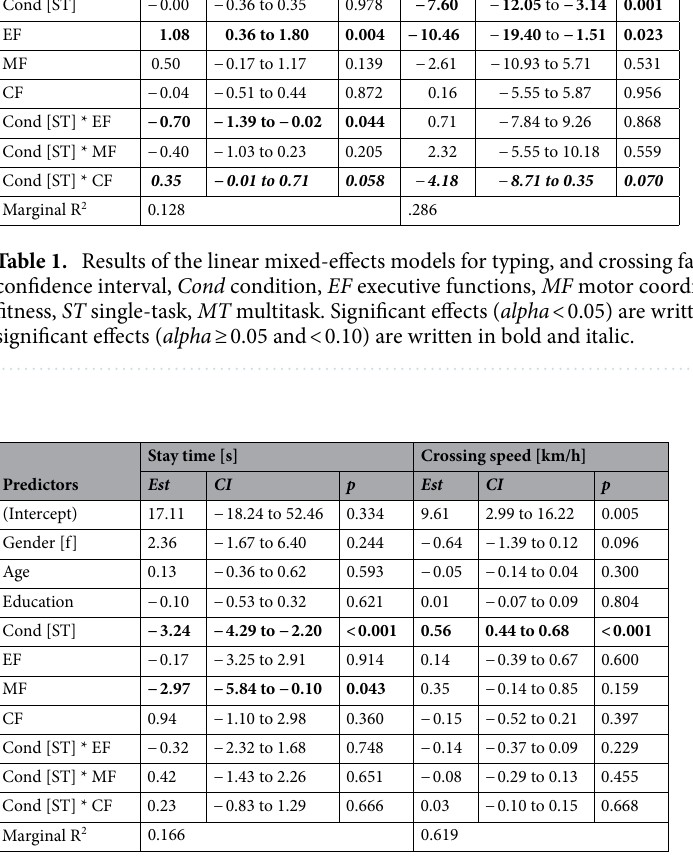
Table 2. Results of the linear mixed-effects models for stay time, and crossing speed. Est estimate, CI confidence interval, Cond condition, EF executive functions, MF motor coordinative fitness, CF cardiovascular fitness, ST single-task, MT multitask. Significant effects ( alpha < 0.05) are written in bold and marginal significant effects ( alpha ≥ 0.05 and < 0.10) are written in bold and